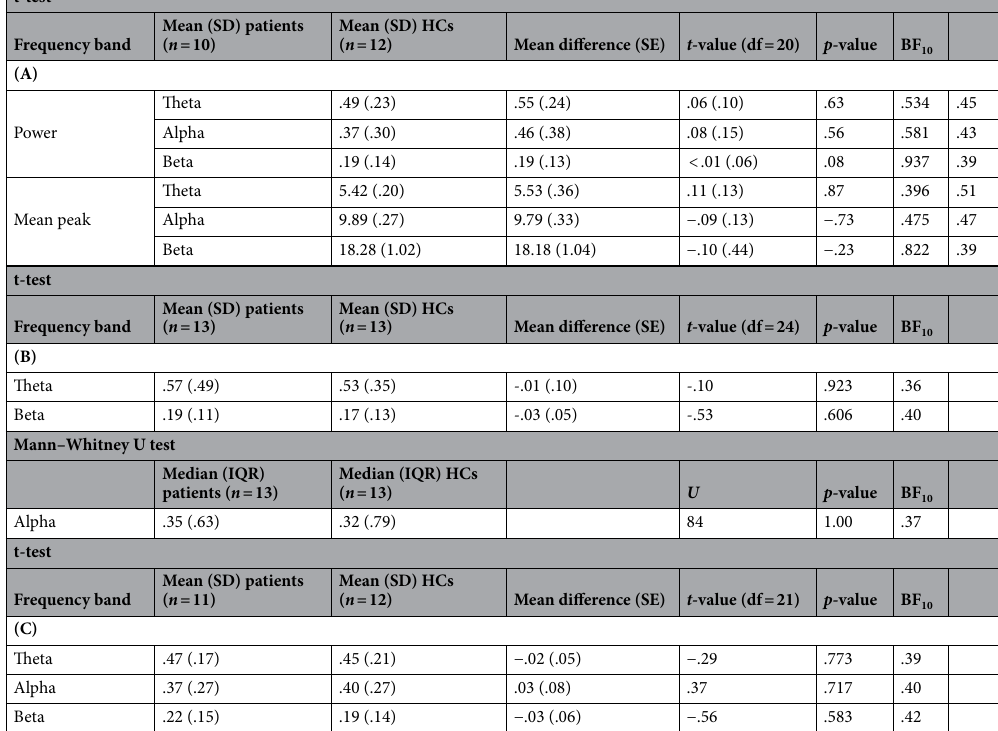
Table 2. Comparisons of global power outcomes (A) and mean peak frequency outcomes during histamine stimulation, (B) during electrical “must-scratch” threshold stimulation, and (C) during painful cold pressor task (CPT) stimulation between patients and healthy controls (HCs). The displayed means are based on the untransformed variables. For the variables, in panel A, beta power, beta mean peak; in panel B, theta and beta power, and in panel C, all displayed frequency bands the t-tests were conducted using square-root transformed variables. SD = standard deviation. SE = standard error. df = degrees of freedom. BF 10 = Bayes factor, evidence towards alternative hypothesis. IQR = inter-quartile range.